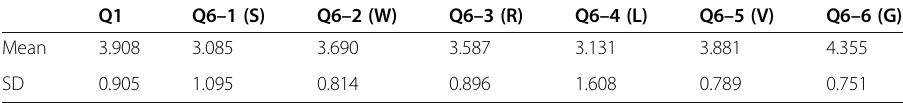
Table 11 Participant perception of the usefulness of CDA score report for each language area